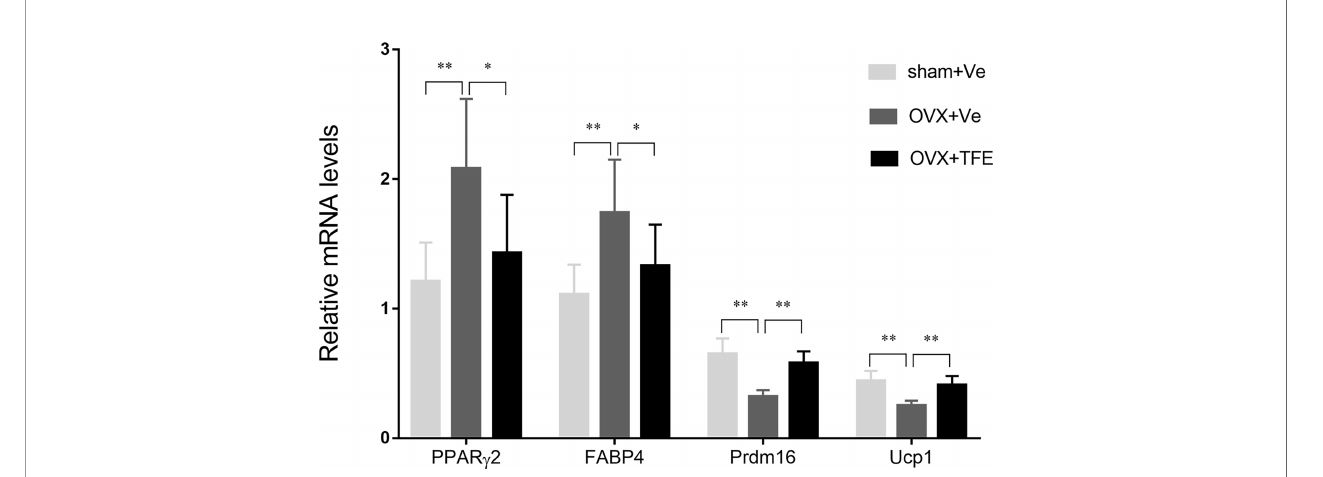
FIGURE 7 | Effects of TFE treatment on marrow white and brown adipocyte gene markers in whole tibiae of OVX rats. Gene expression markers of Prdm16 and Ucp1 were normalized to FABP4 expression in the same sample. OVX, ovariectomy; Sham, sham-operation; TFE, total fl avonoids of Epimedium; Ve, vehicle. Results are presented as means ± SD (Sham, n = 11; OVX, n = 10; TFE, n = 11). * P <0.05 and ** P <0.001 between groups analyzed by One-way ANOVA with Bonferroni-correction.